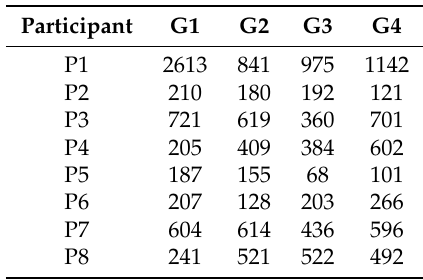
Table 4. The length of each of the 4 gestures used by each participant are presented. The table displays the variability of the length of the gestures. Fluctuations of the gesture lengths are observed between participants and between gestures. We can clearly observe that there is no particular tendency in terms of the lengths of the selected input sequences. The length is measured by the frames recorded for each sequence, with the average frame rate of the device being 100 frames per second. Participant G1 G2